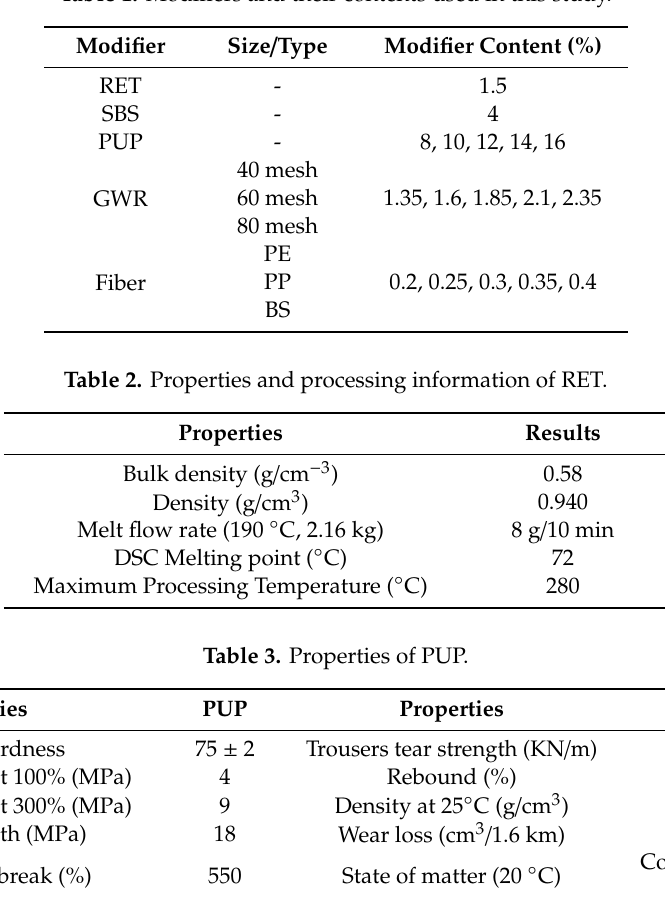
Table 1. Modifiers and their contents used in this study.